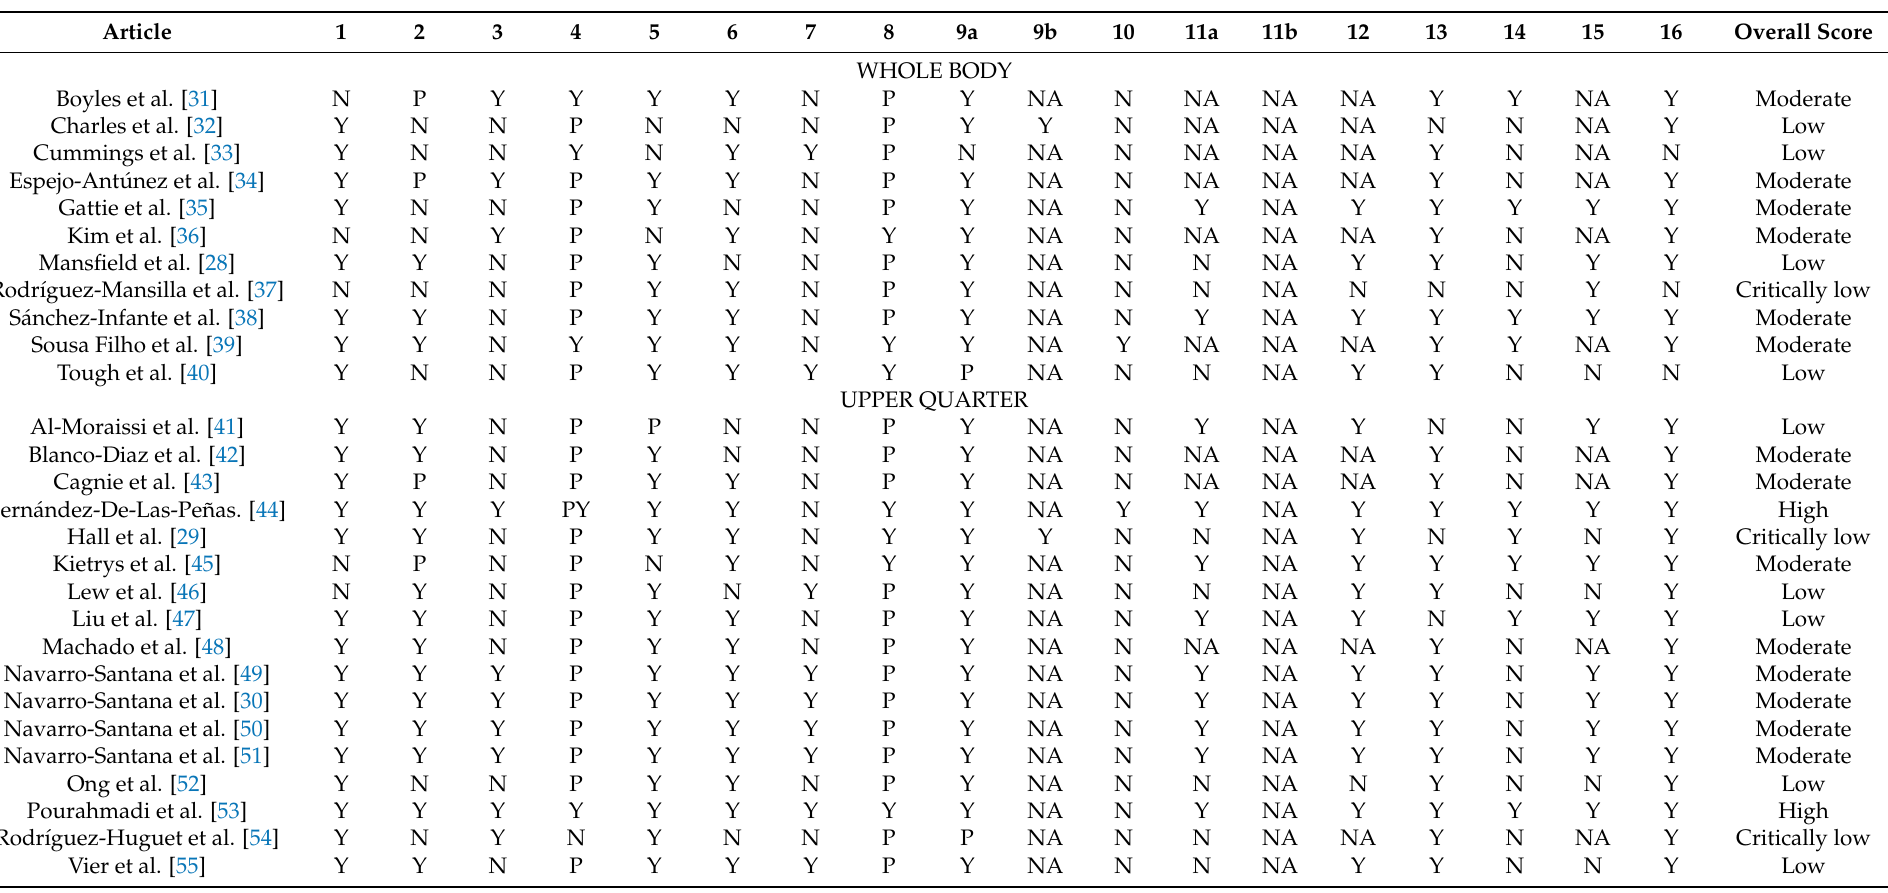
Table 1. AMSTAR Quality